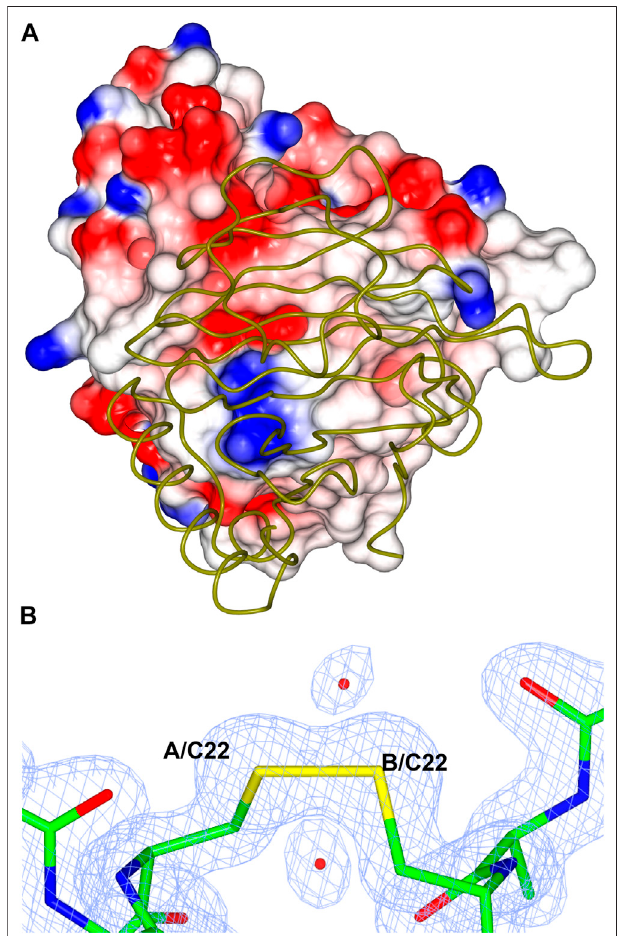
FIGURE 12 | (A) A cartoon diagram showing the hydrophobic interactionsatthedimerinterfaceofTsLI.Theelectrostaticsurfacepotentialof one monomer of TsLI that has been rotated by 90 ° around the vertical axis from that presented in Figure 7 is shown together with the other monomer of the dimer shown as an α -C backbone (green). The areas of positivechargeareshowninblue, withtheareasofnegativechargeinredand the hydrophobic surfaces are represented in white. (B) Detail of the electron density showing the intersubunit disul fi de bond formed by the cysteine 22 of each monomer.The2Fo — Fc(blue)iscontoured at1.3 σ andtheFo — Fcmap is contoured at 3.0 σ (green) and − 3.0 σ